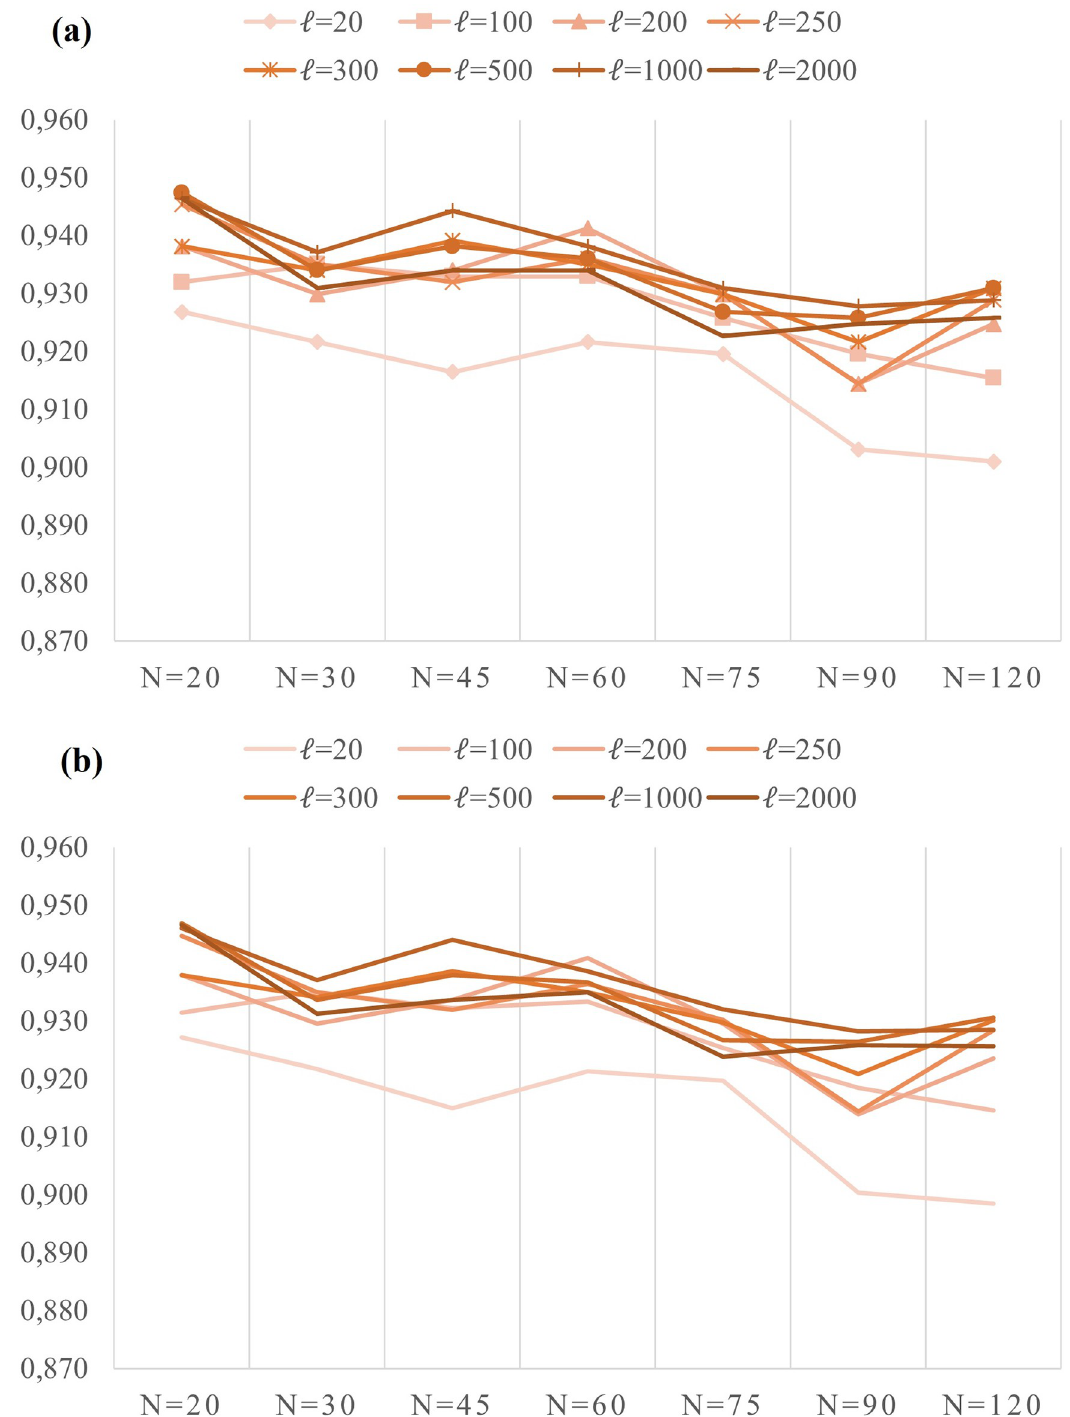
Fig 6. 5-fold average results of test sets given in the Tables 2 and 3. (a) Accuracy (b) F1 score.